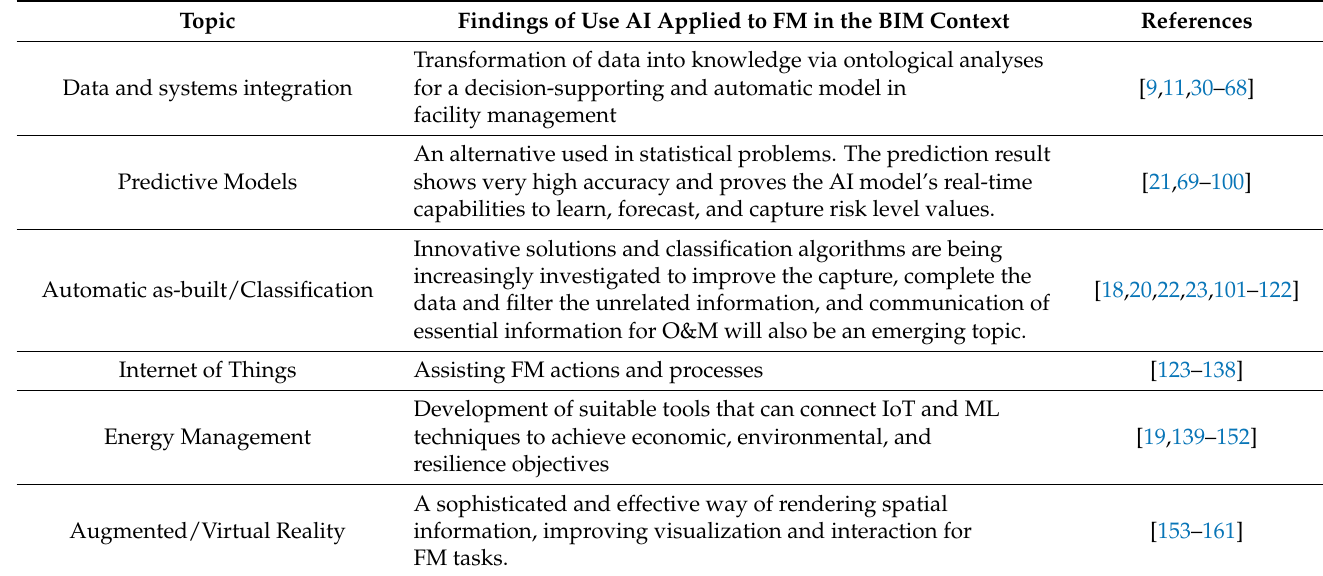
Figure 6. AI applied to FM in the BIM context categories in terms of the number of journals. Table 3. References by topics and main